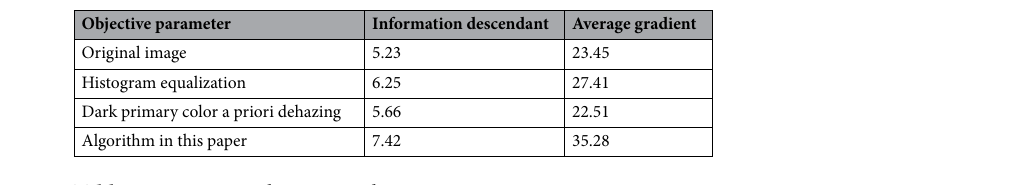
Table 1. Figure 10 Objective evaluation